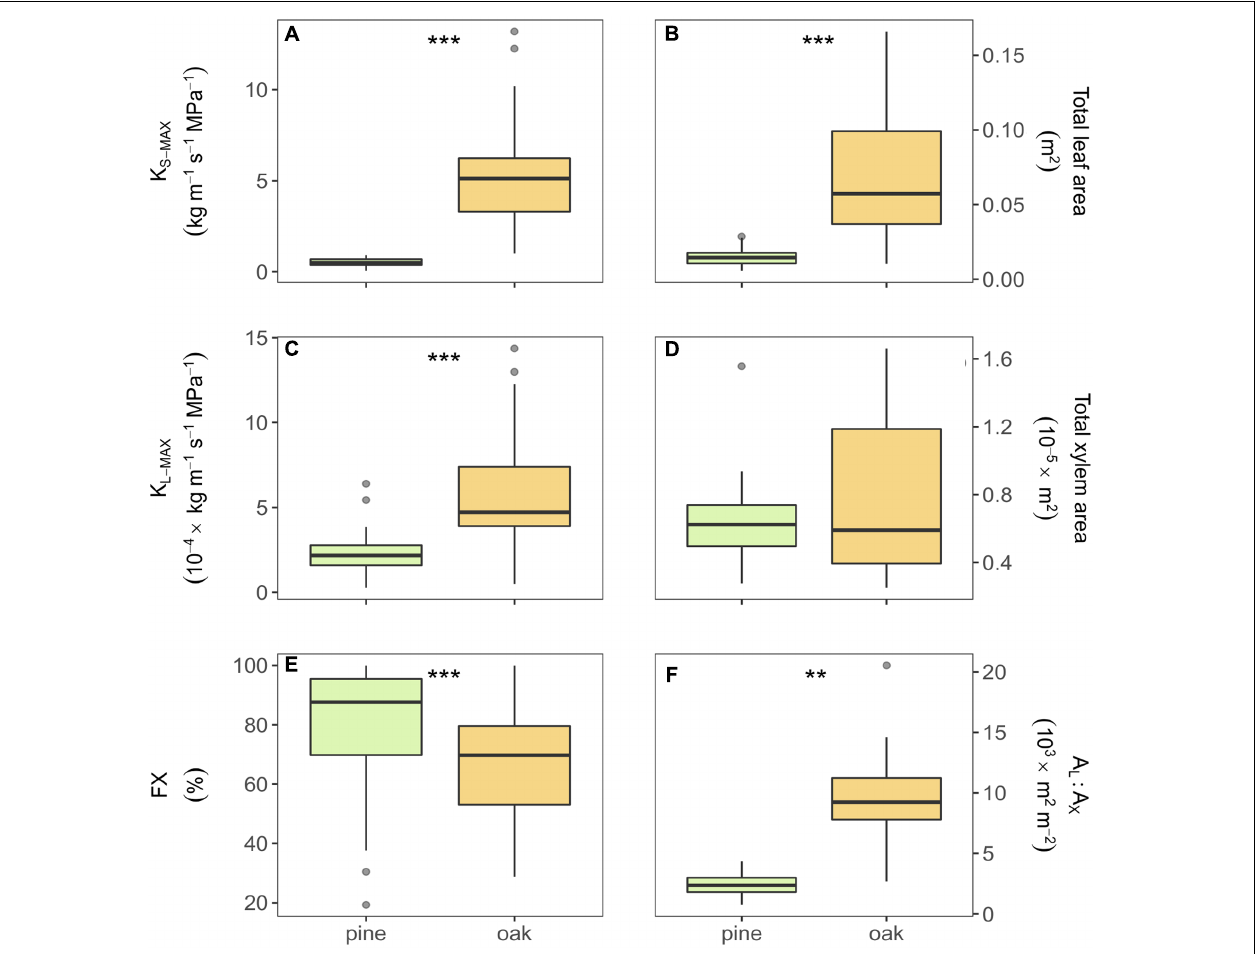
FIGURE 2 | Boxplots of the different hydraulic traits of Scots pine and sessile oak: (A) xylem-specific maximum hydraulic conductivity, (B) total leaf area, (C) leaf-specific maximum hydraulic conductivity, (D) total xylem area, (E) functional xylem fraction, and (F) leaf-to-xylem area ratio. Boxes represent 50% of the data (between the first and third quartiles). Median is shown as horizontal line. Bars extend from the box to the highest/lowest value within 1.5 ∗ inter-quartile range (IQR). Points (outliers) are values > 1.5 ∗ IQR. K S - MAX , xylem-specific maximum hydraulic conductivity; K L - MAX , leaf-specific maximum hydraulic conductivity; A L : A X , leaf-to-xylem area ratio; FX, functional xylem fraction. ∗∗ Indicate p -value < 0.01 and ∗∗∗ indicate p -value <